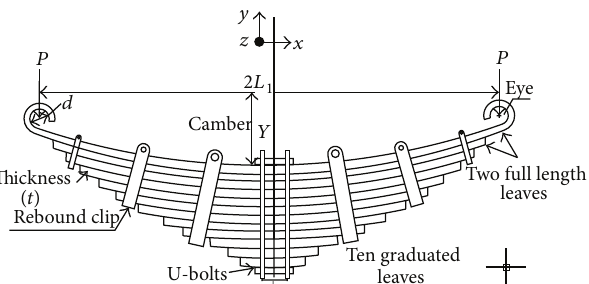
Figure 1: Typical leaf spring structure showing symmetry about central U-bolt.